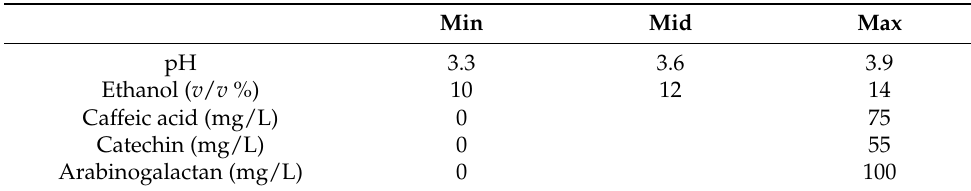
Table 1. Experimental conditions varied in the model wine solutions containing protein Bovine Serum Albumin (BSA) 1